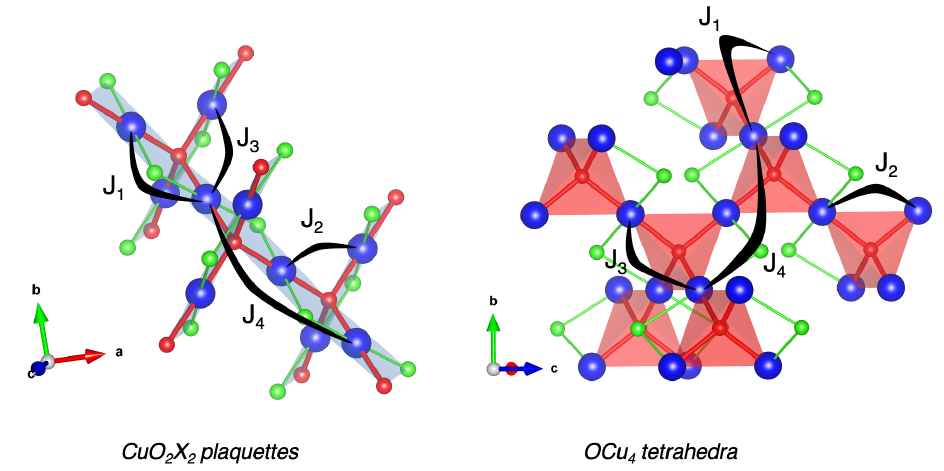
Figure 4. Representation of J exchange couplings between copper sites in both CuO 2 X 2 - and OCu 4 - based frameworks. Cu, O and X atoms are depicted by blue, red and green spheres, respectively. CuO 2 X 2 plaquettes and OCu 4 tetrahedra are shown in transparent blue and red,